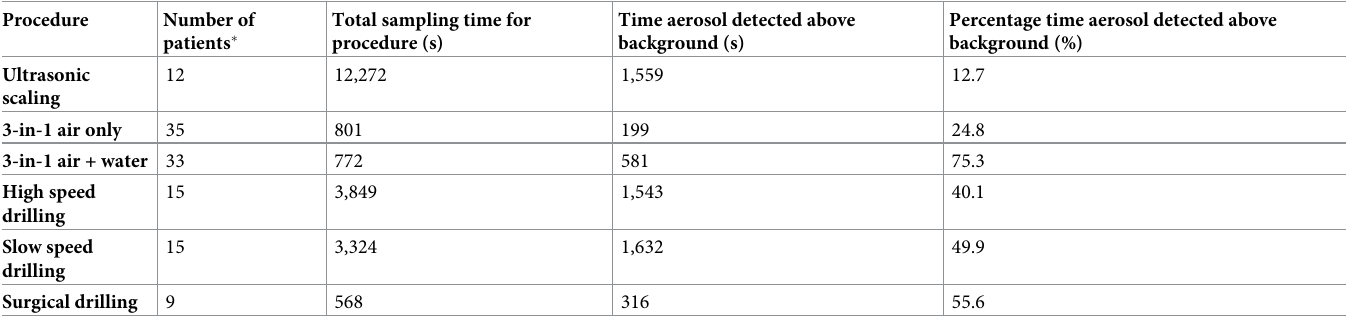
Table 1. Dental procedures for which aerosol was detected above